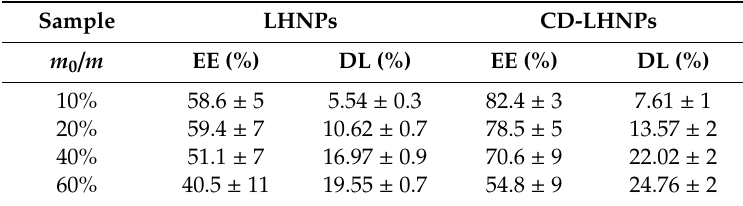
Table 2. Variation of drug loading and encapsulation in LHNPs and CD-LHNPs with m 0 / m . Sample LHNPs